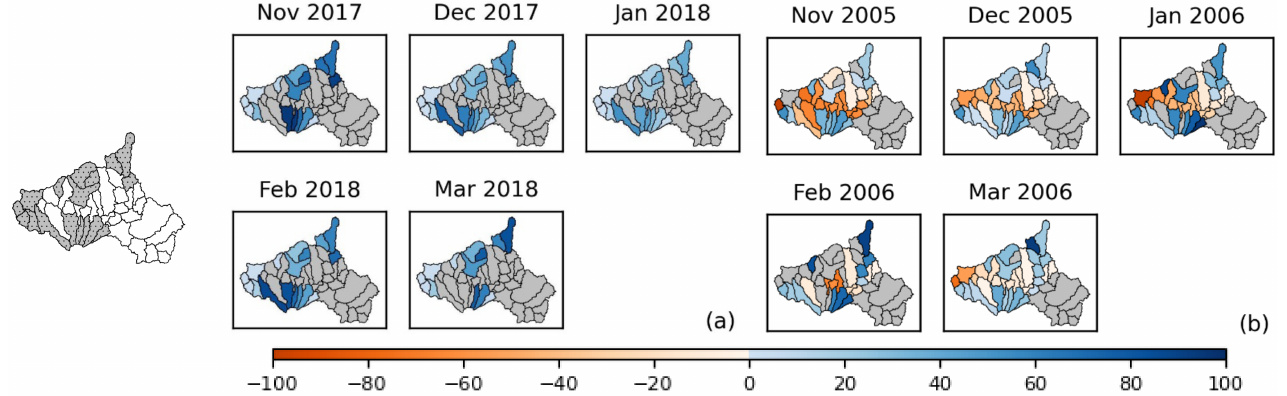
Figure 14. Drought severity change in percentage in the subbasins where the measure is applied, agricultural drought event VII ( a ). Drought severity change in percentage in the subbasins where the measure is applied and in downstream subbasins, hydrological drought event I ( b ). The location of the measure is presented on the left side of the